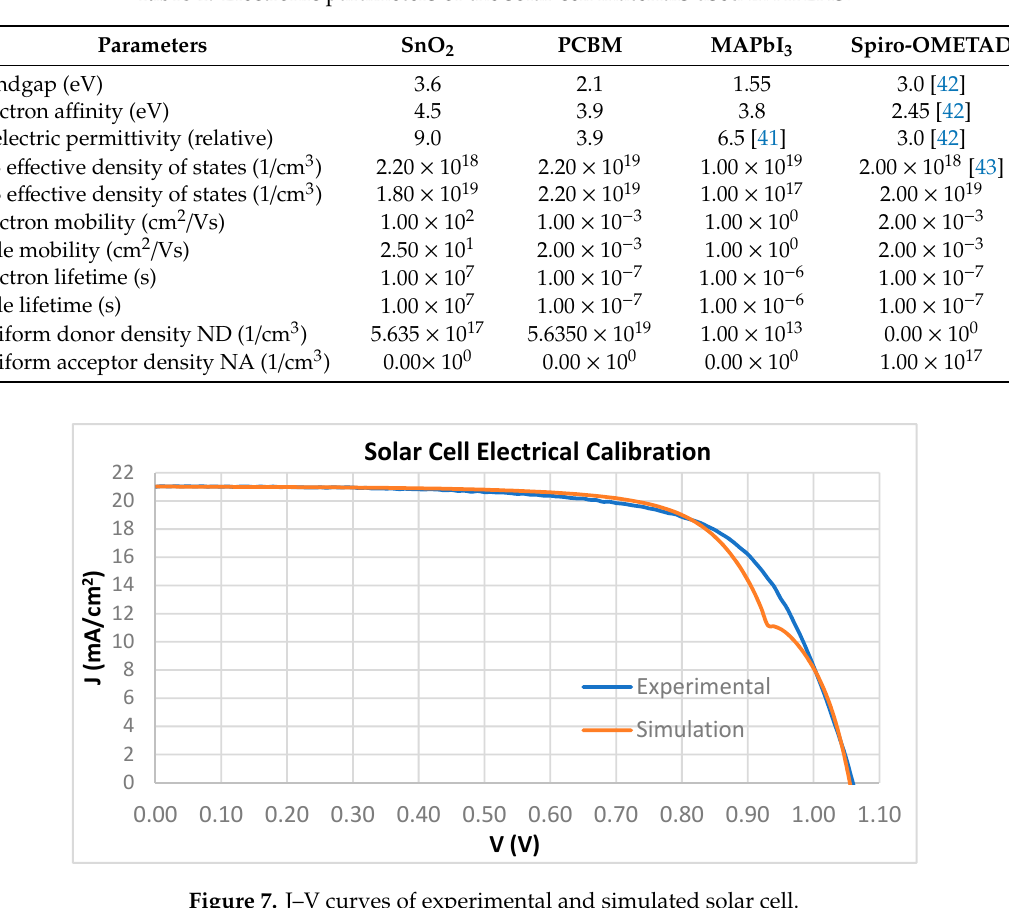
Table 1. Electronic parameters of the solar cell materials used in ATLAS.